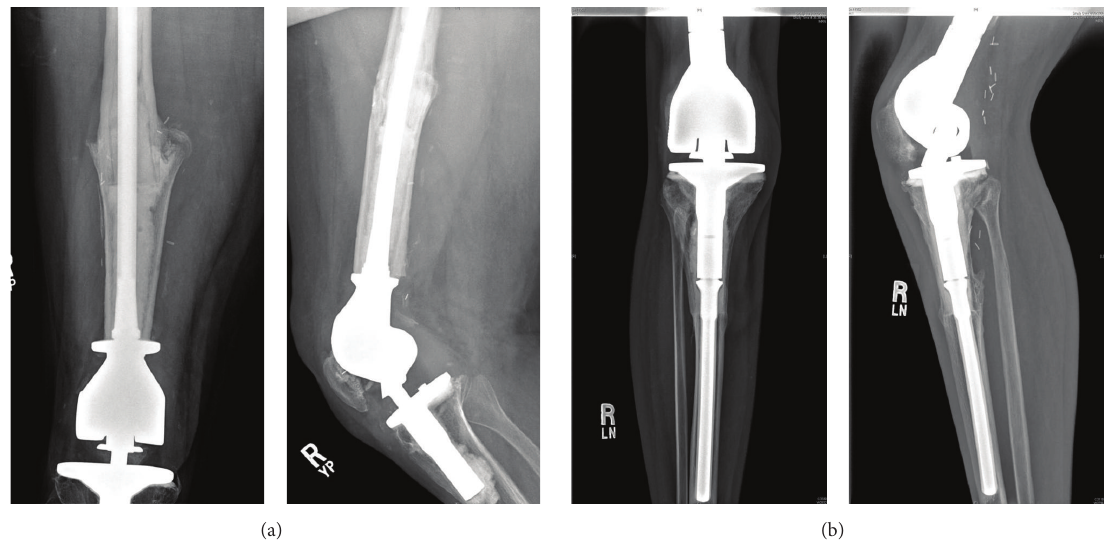
Figure 3: Standard reconstructions for Group 2. (a) Distal femoral APC. (b) Proximal tibia